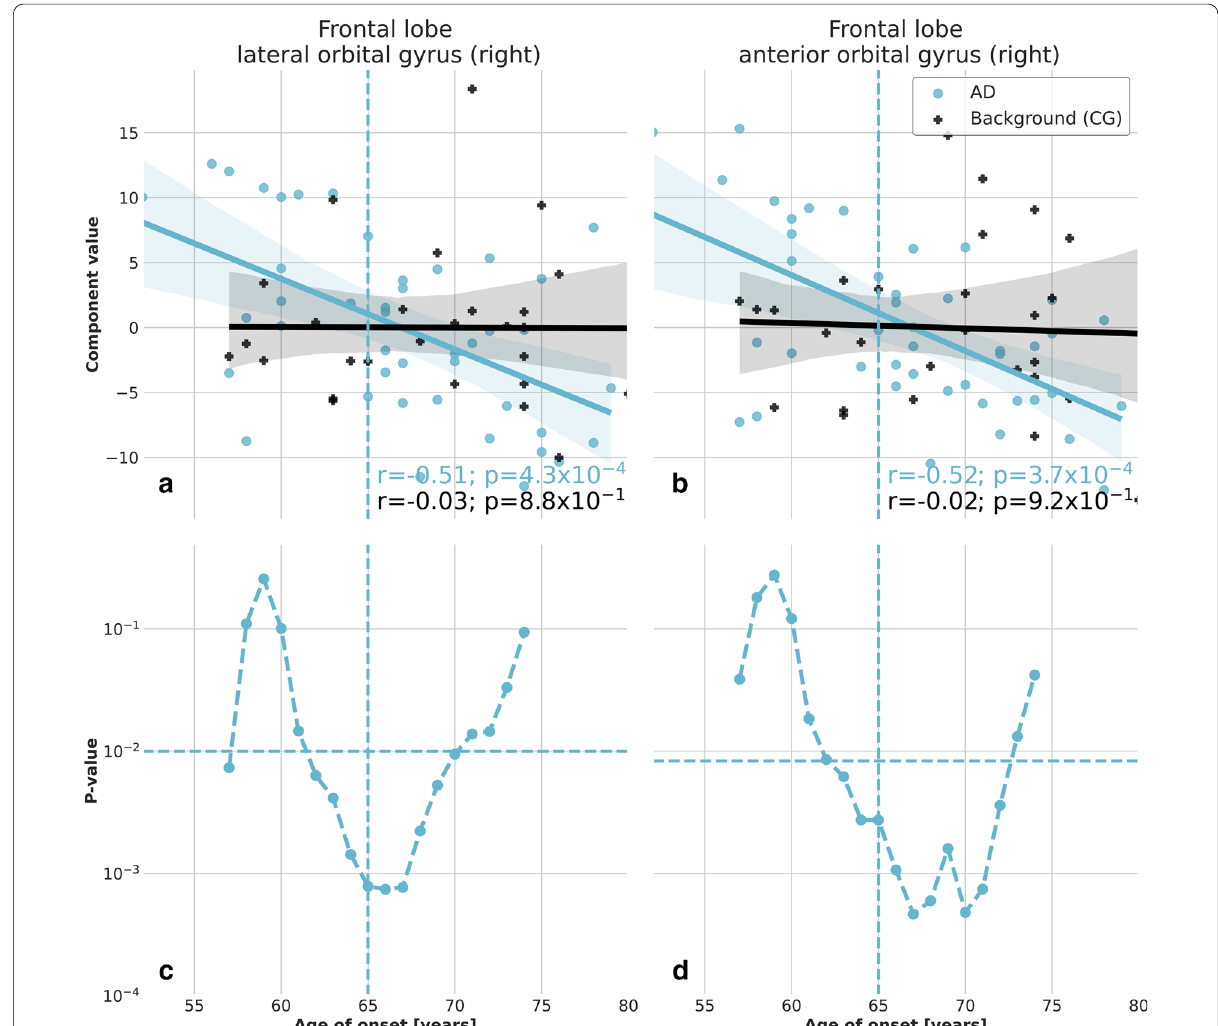
Fig. 5 Correlation of the significant principal components and age of onset of AD in the frontal lobe. Principal components exhibiting significant correlation with the age of onset of AD (cid:31) | r | > 0.5 ; P < 0.05 / N r ind (cid:30) . A linear regression with 95% confidence bands is shown on the plots for better visualization of the correlations. The features extracted from AD patients in the right lateral orbital gyrus of the frontal lobe ( a ) and in the right anterior orbital gyrus of the frontal lobe ( b ) exhibit a significant difference with respect to the background estimated from control subjects, as confirmed also by the Student’s t -test on the distributions of the two patient categories with respect to a threshold age A ( c , d ).